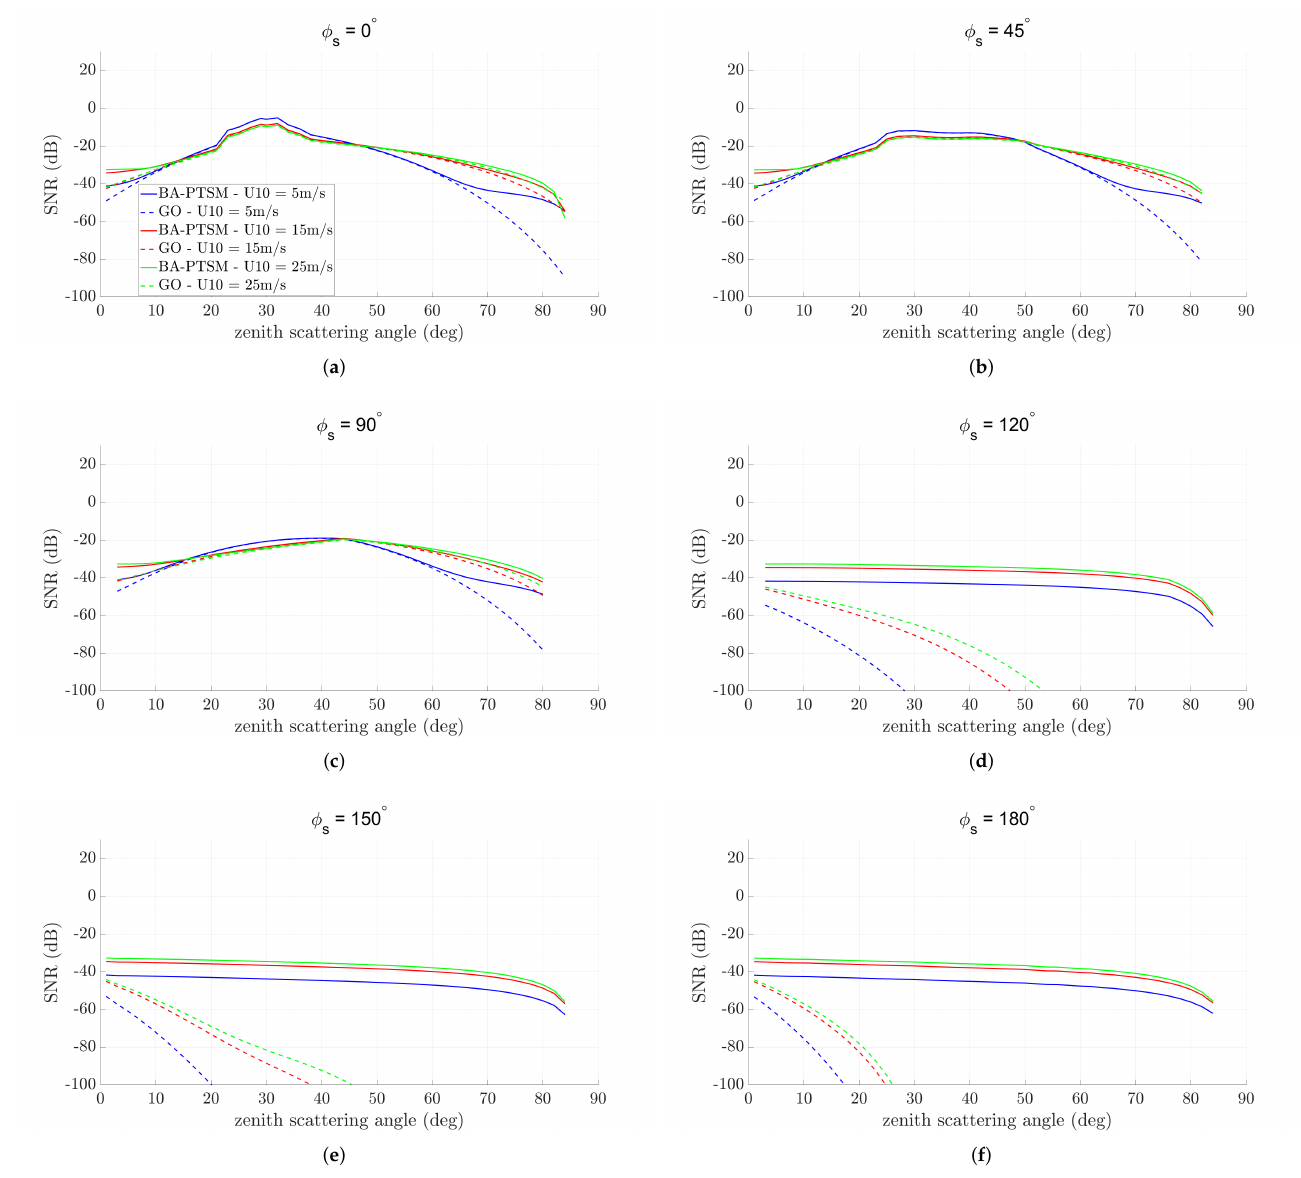
Figure 4. SNR in RR polarization for a spaceborne GNSS-R receiver obtained using BA-PTSM (solid lines) and GO (dashed lines) for wind speed 5 m/s (blue lines), 15 m/s (red lines), and 25 m/s (green lines). ( a ) φ s = 0 ◦ ; ( b ) φ s = 45 ◦ ; ( c ) φ s = 90 ◦ ; ( d ) φ s = 120 ◦ ; ( e ) φ s = 150 ◦ ; ( f ) φ s = 180 ◦